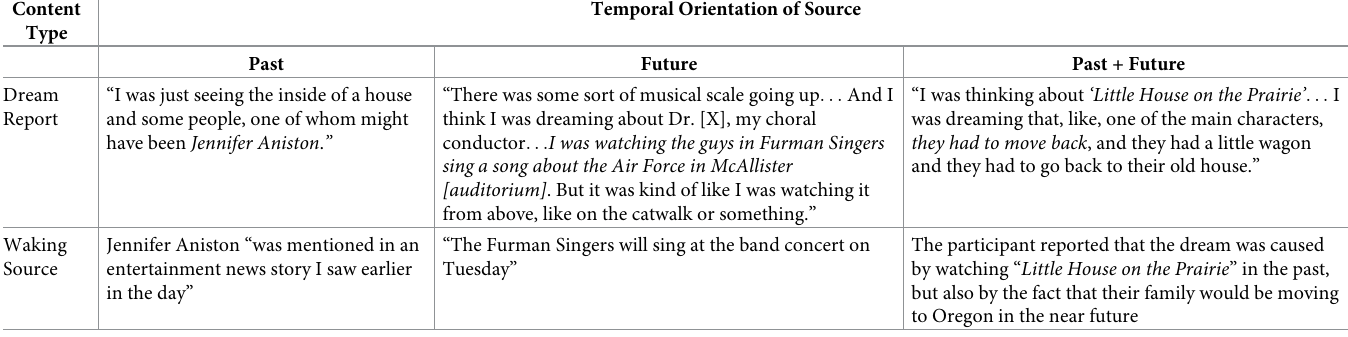
Table 1. Example past and future episodic sources. Content